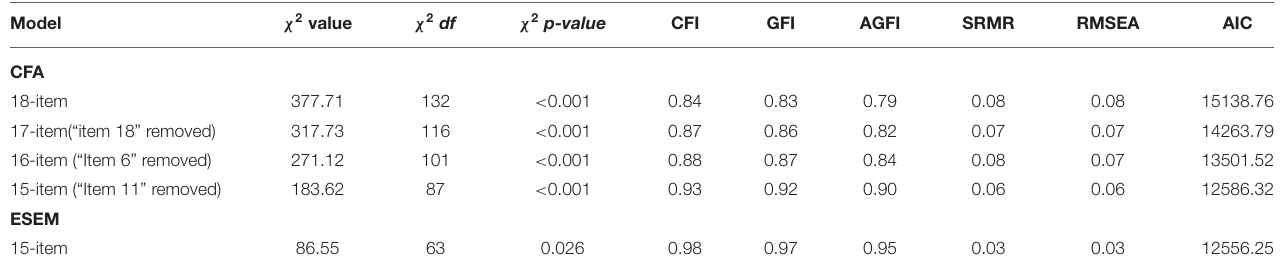
TABLE 4 | FASM function confirmatory factor analysis model comparisons ( N = 302).